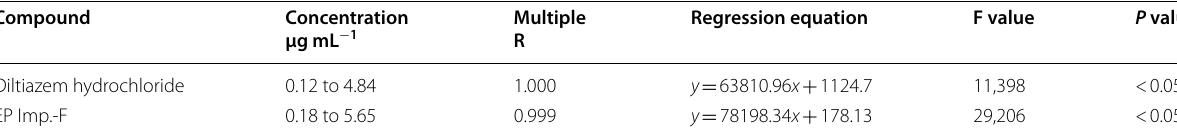
Table 5 Regression statistics of linearity experimental results Compound